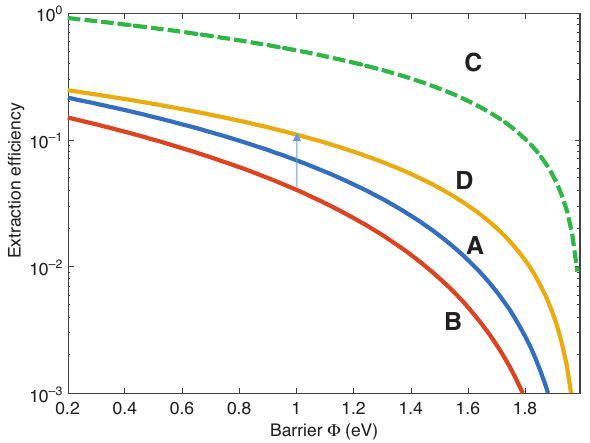
Figure 14: Extraction efficiency of the hot carriers generated on the metal/TiO interface by the SPPs excited with λ = 620 nm photons. 2